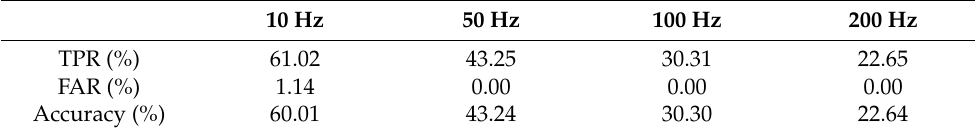
Table 1. Detection performances of Standard SNEO at different firing rates at SNR = 0 dB (C = 5).